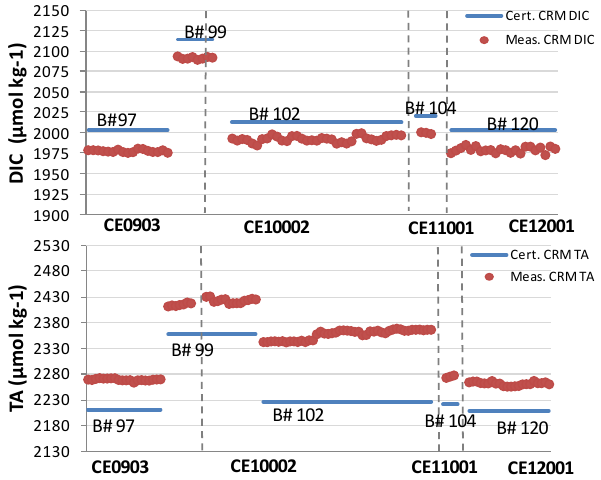
Figure 2. DIC and TA CRM measured values plotted against cer- Figure 2 DIC and TA CRM measured values plotted against certified values for each of the tified values for each of the surveys. Dashed lines indicate a new surveys. Dashed lines indicate a new survey. survey. Table 3 Accuracy and precision of DIC and TA in µ mol kg -1 for each of the surveys, calculated as the average and standard deviation, respectively of the differences between duplicate samples, where n is the number of duplicate samples.